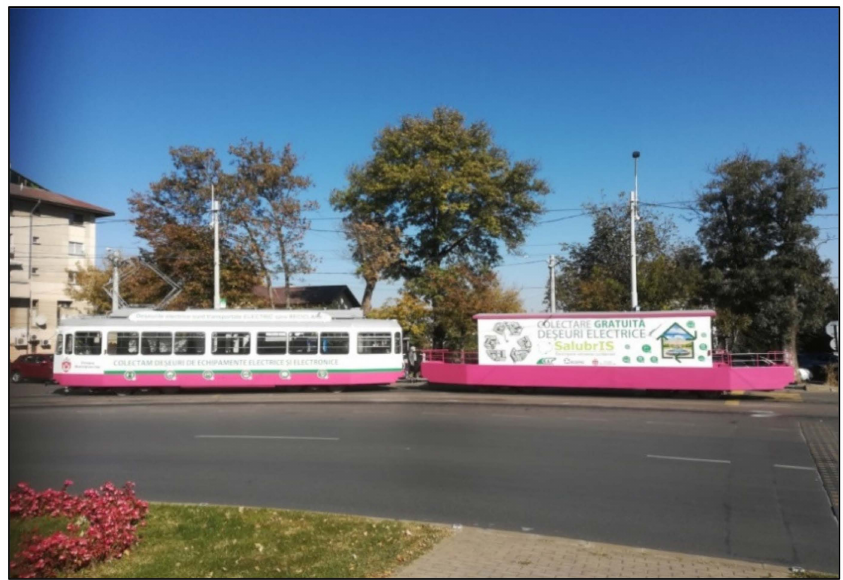
Figure 6. Recycling tram in Iasi city 2021—operating on weekends on several key stations (Photo FCM on 10 October